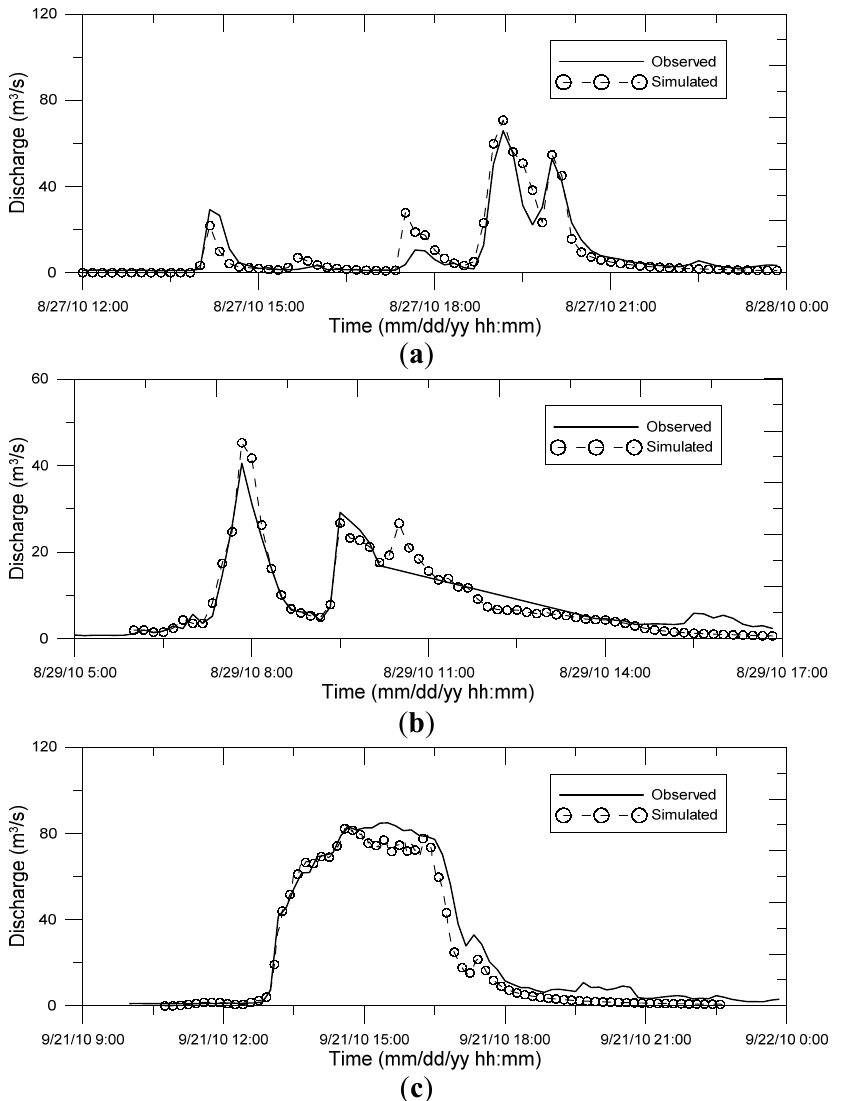
Figure 7. Observed and simulated flow on ( a ) 27 August 2010; ( b ) 29 August 2010; ( c ) 21 September